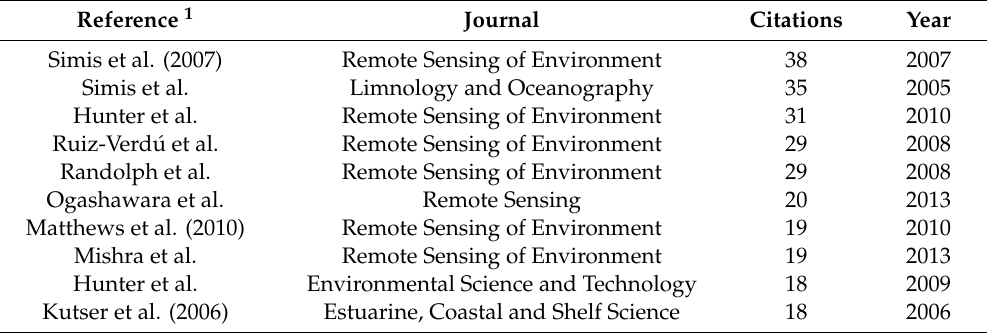
Table A1. Top 10 most cited documents in the field of remote sensing of